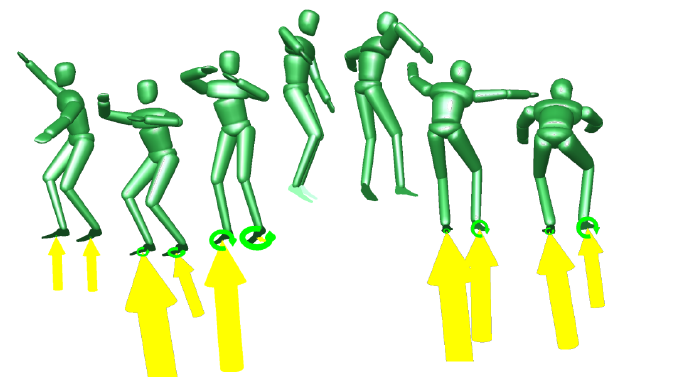
Figure 5. The result of this work: A fully dynamic reconstruction of a jumping motion with rotation. The contact forces and torques are visualized.